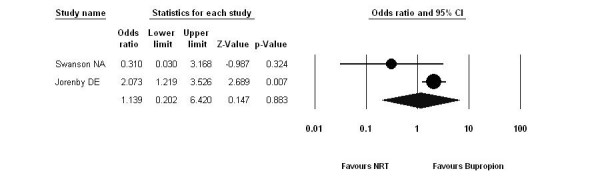
Random Effects Meta-Analysis. NRT vs. Bupropion at 12 months. I2 = 59%.